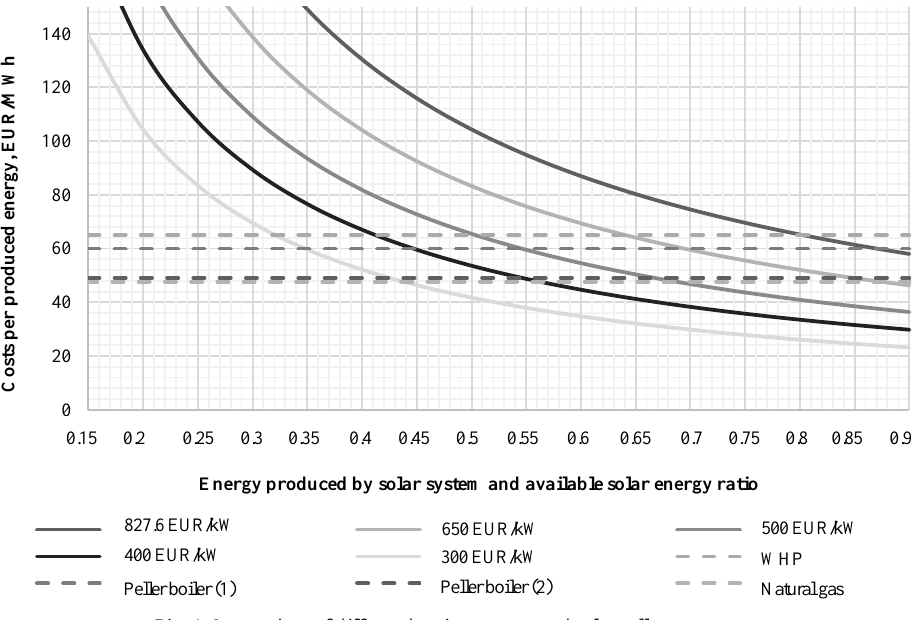
Fig. 3. Calculated solar collector system performance ratio.